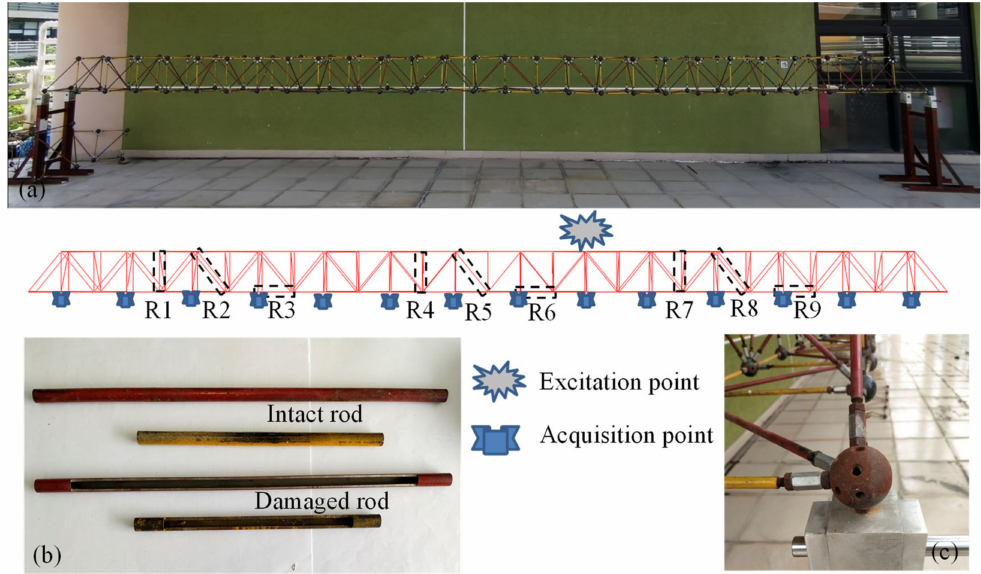
Figure 5. The steel frame model with 355 rods. ( a ) Model layout; ( b ) intact and damaged rods; ( c ) boundary condition.